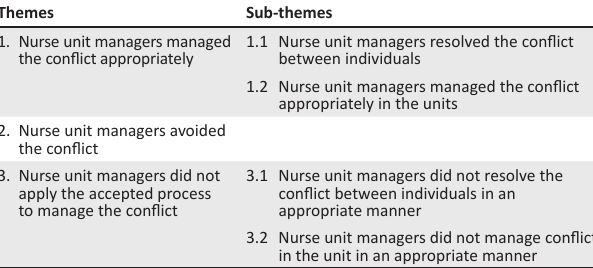
TABLE 3: Demographic profiles of the participants. TABLE 2: Classification of